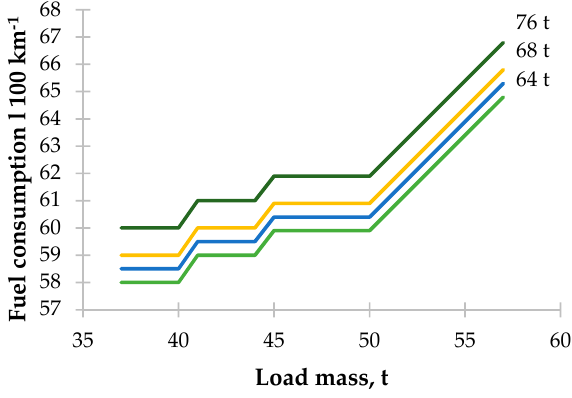
Figure 4. Average fuel consumption of timber transportation vehicles.